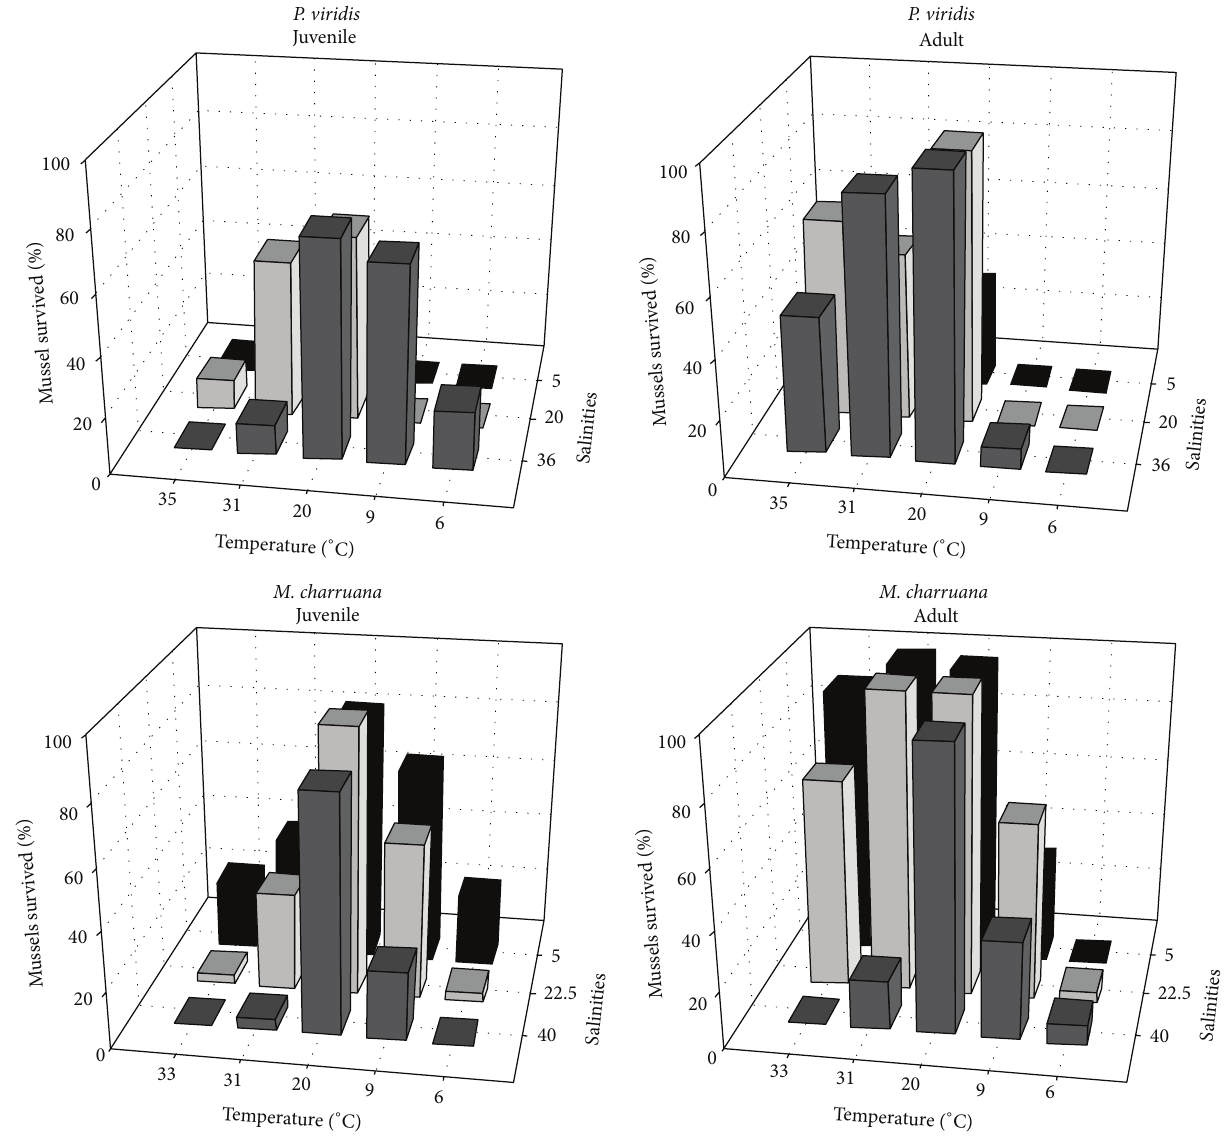
Figure 4: Final survival of Perna viridis in the salinity-temperature interaction experiments for juveniles and adults. Final survival of Mytella charruana in the salinity-temperature interaction experiments for juveniles and